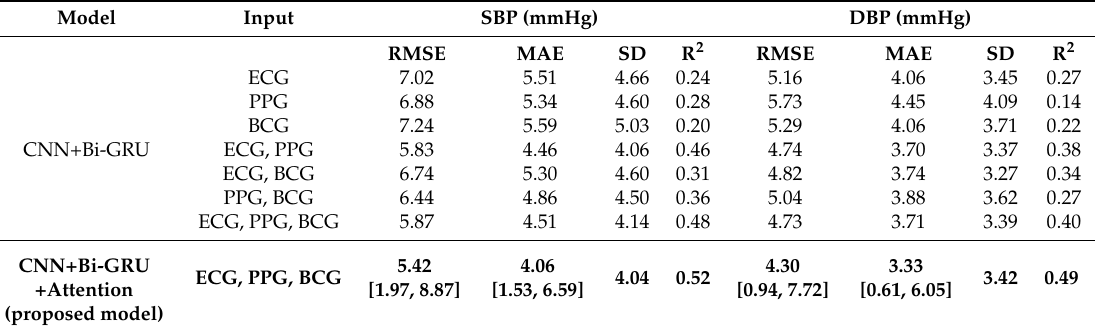
Table 3. Performance comparison for combinations of input signals without attention model and with attention. The 95% confidence interval is indicated below the error of the proposed model.